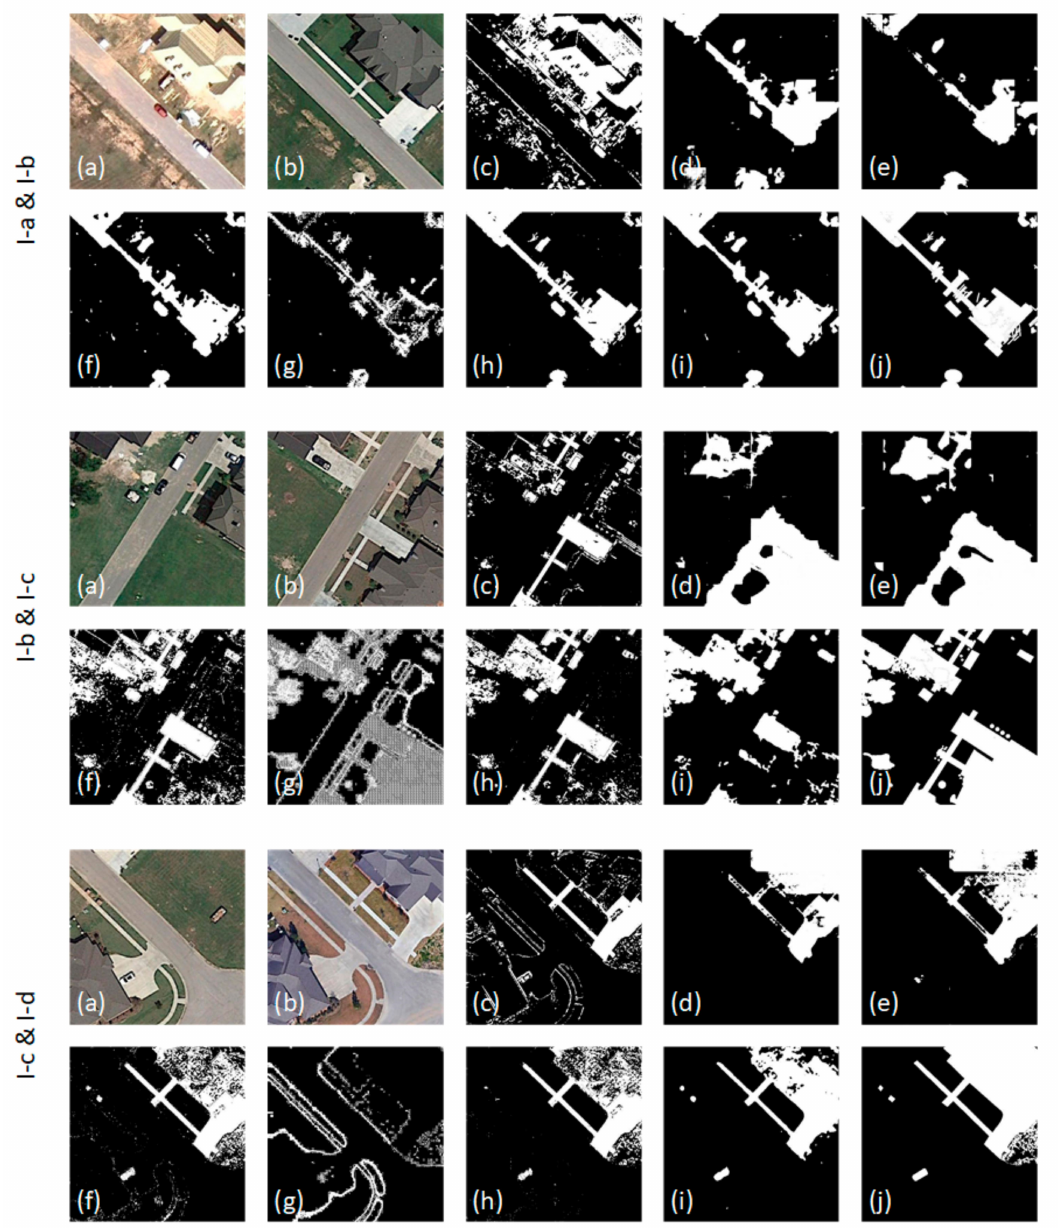
Figure 8. Change detection results of the comparative methods on dataset I: ( a ) pre-event image, ( b ) post-event image, ( c ) CVA, ( d ) GETNET, ( e ) PCANet, ( f ) GAN, ( g ) DSCN, ( h ) DLSF, ( i ) our PDA, ( j ) ground